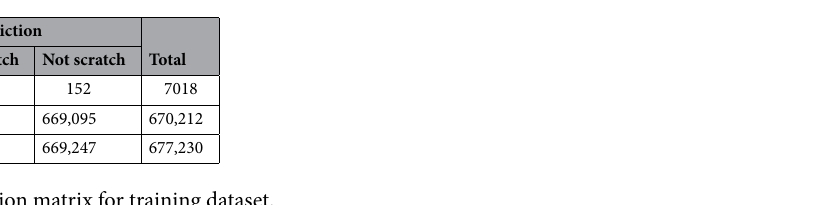
Table 1. Confusion matrix for training